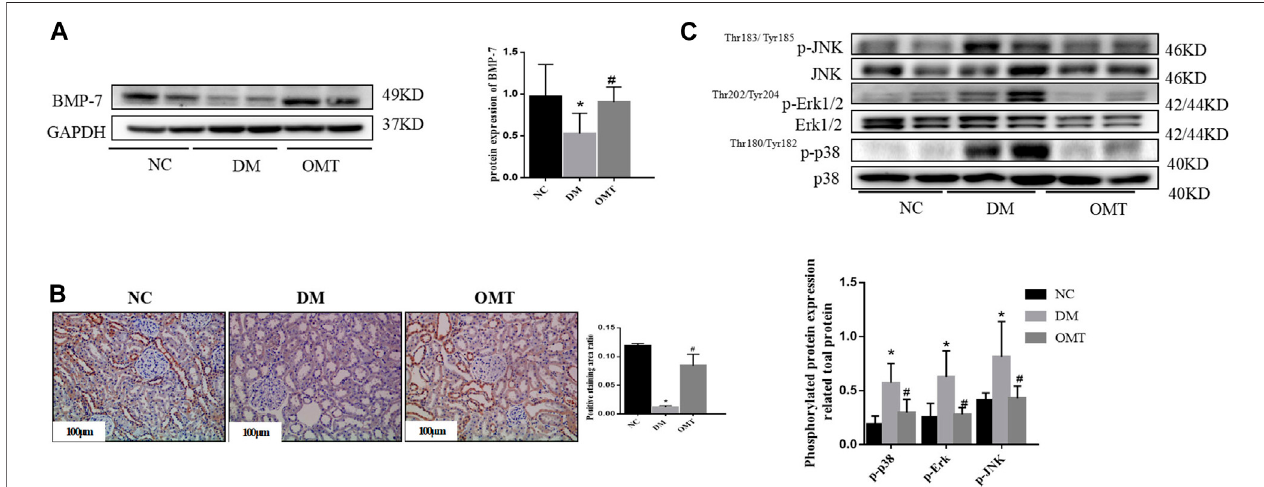
FIGURE 11 | (A) Detection of BMP-7 proteins after OMT intervention. Western blot was used to detect the change of BMP-7 expression level after OMT intervention, * p < 0.05 vs. NC group, # p < 0.05 vs. DM group. (B) The immunohistochemical technique was used to detect the expression of BMP-7 in the paraf fi n sections of rat kidney tissues in each group (scale bar is 100 μ m), and the ratio of the positive staining area to the total area of the tissue under each fi eld was counted, * p < 0.05vs.NCgroup,# p < 0.05vs.DMGroup (C) DetectionofMAPKpathway-relatedproteinsafterOMTintervention.Westernblotwasusedtodetectp38,Erk and JNK phosphorylation levels after OMT intervention, * p < 0.05 vs. NC group, # p < 0.05 vs. DM